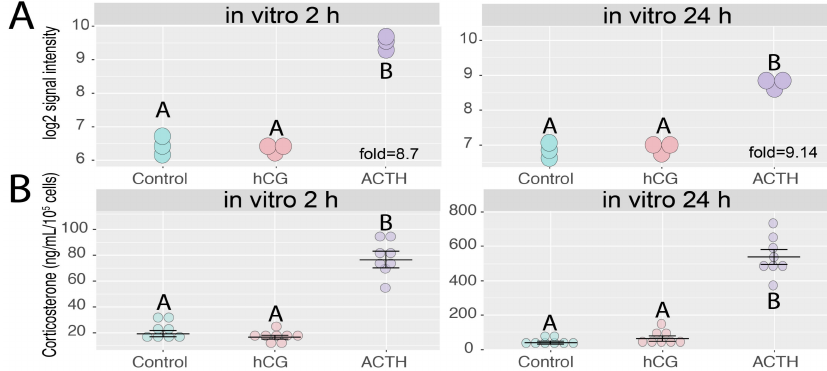
Figure 5. Effect of ACTH and hCG on Giot1 gene expression in primary adrenocortical cells. ( A ) Cells were collected for RNA isolation 2 and 24 hours after administration of the tested compounds. Data extracted from normalized gene expression dataset of Affymetrix Rat Gene 2.1 ST Array, presented as a dot plot in log2 signal intensity scale. Expression fold change was calculated in relation to control group ( n = 3); ( B ) effect of hCG and ACTH on corticosterone secretion in primary rat adrenocortical cells. At day 4 of culture, cells were exposed to hCG (10 − 7 M), or ACTH (10 − 7 M). Cell culture media were collected at 2 h and 24 h following drug treatment. Corticosterone concentration was determined by ELISA. Data are presented as means ± SEM, n = 8. Statistical analysis of the data was performed by using one-way analysis of variance (ANOVA) followed by Tukey’s HSD test. Groups sharing the same letter are not significantly different according to Tukey’s HSD